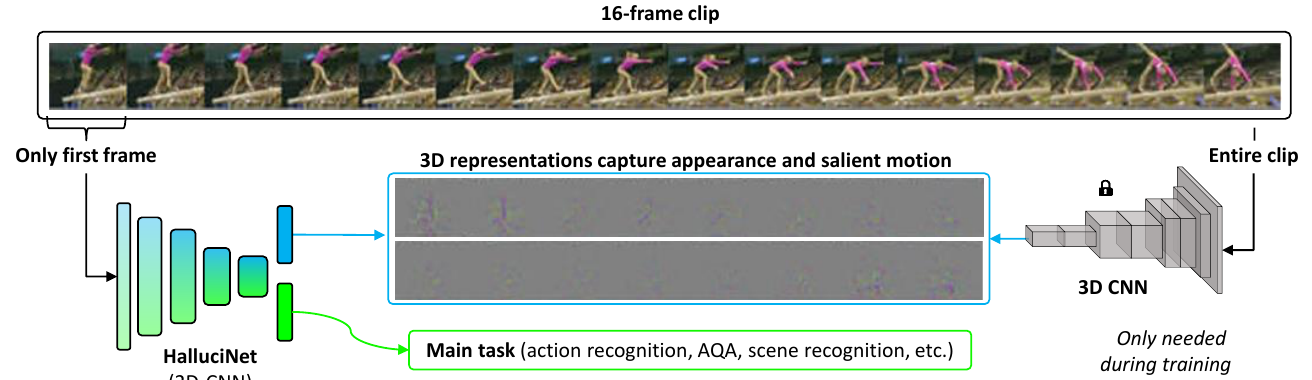
Figure 1. Multitask learning with HalluciNet. HalluciNet (2D-CNN) is jointly optimized for the main task and to hallucinate spatiotemporal features (computed by an actual 3D-CNN) from a single